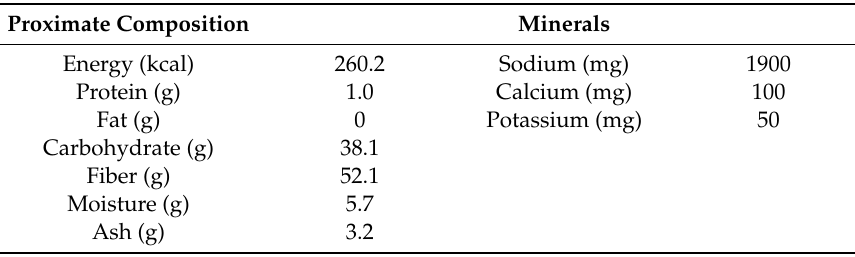
Table 5. Nutrient composition of pectin fiber.